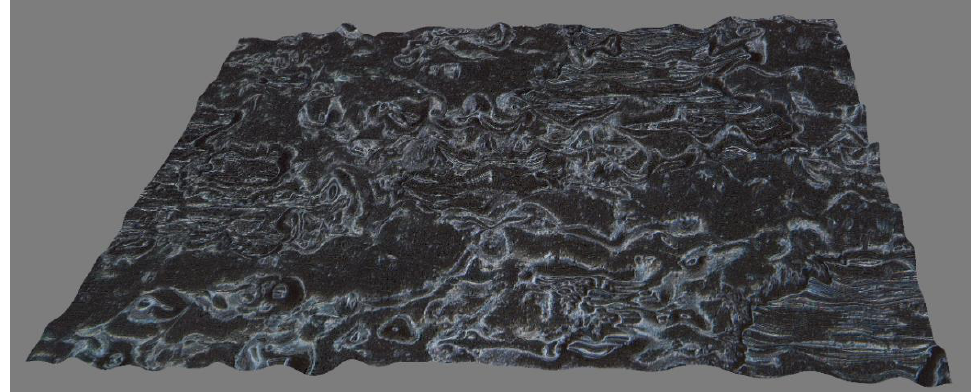
Figure 3. Surface morphology of M21C prepreg.